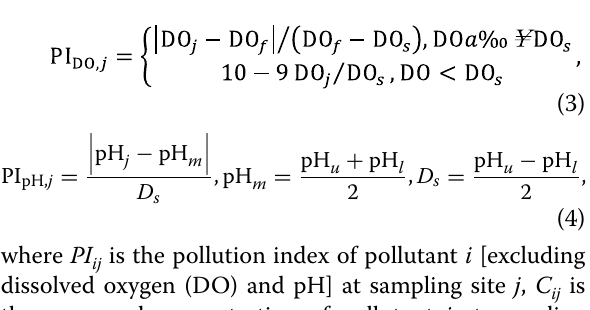
tional file 1: Table S1.